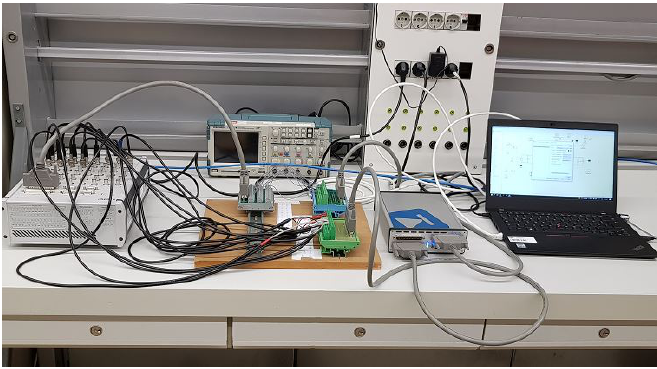
Figure 9. The experimental HIL set-up of the PV